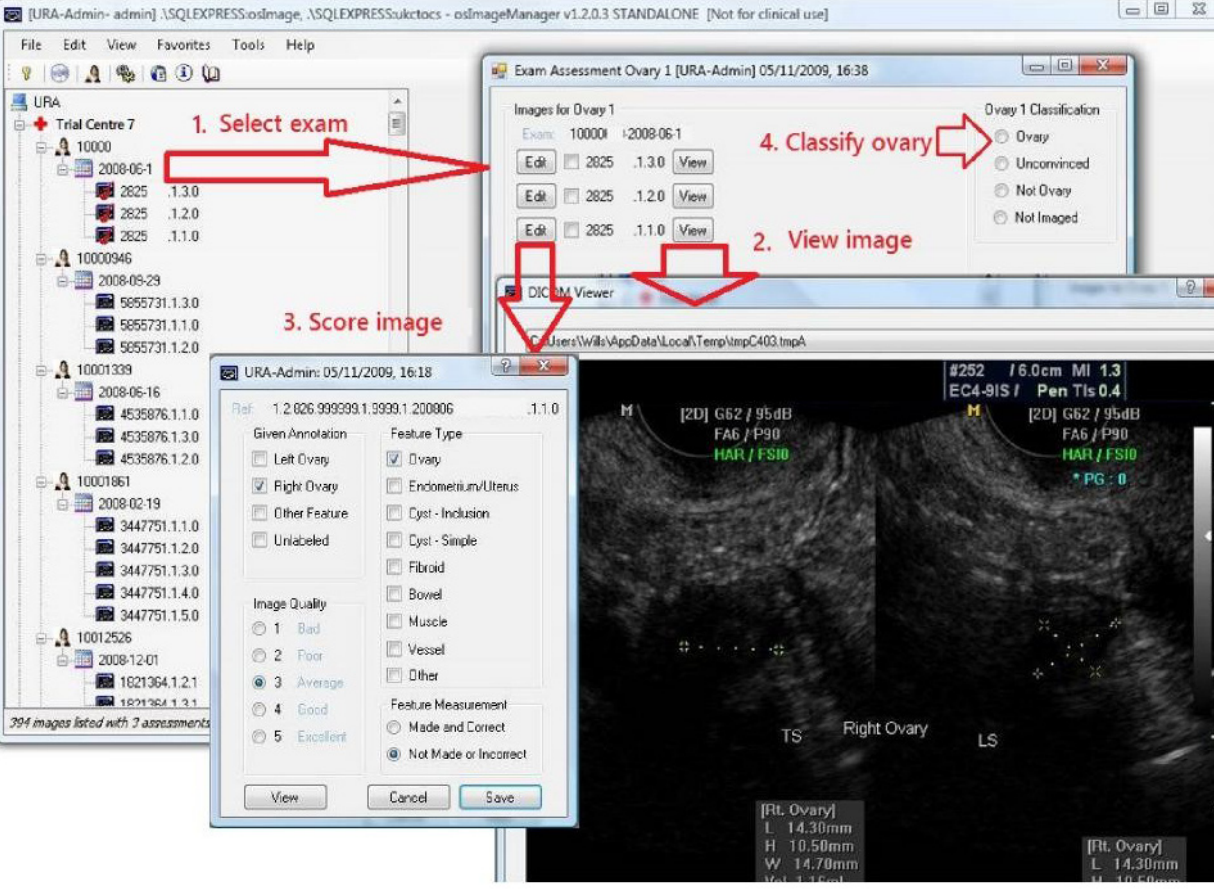
Figure 2. Screenshots of the osImageManager – the application used to facilitate Transvaginal Ultrasound Exam